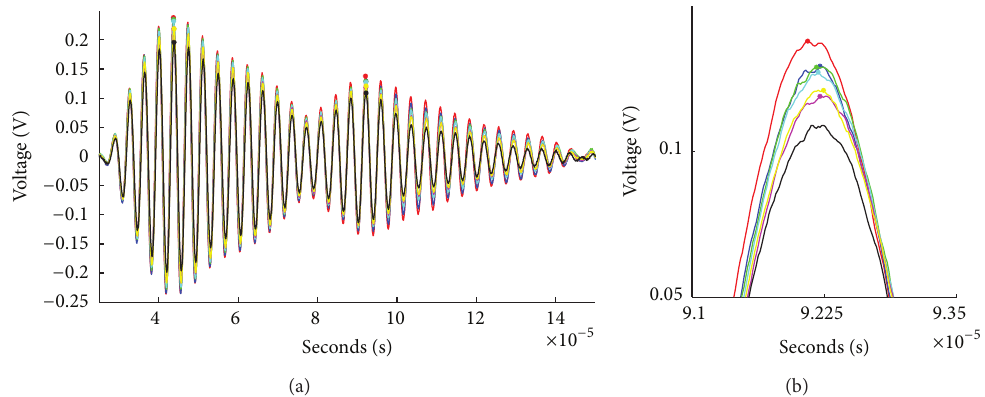
Figure 3: (a) Recieved Lamb wave signals at all seven damage states along path 𝐴 - 𝐺 (left) and (b) closeup of 𝐴 0 wave (right).